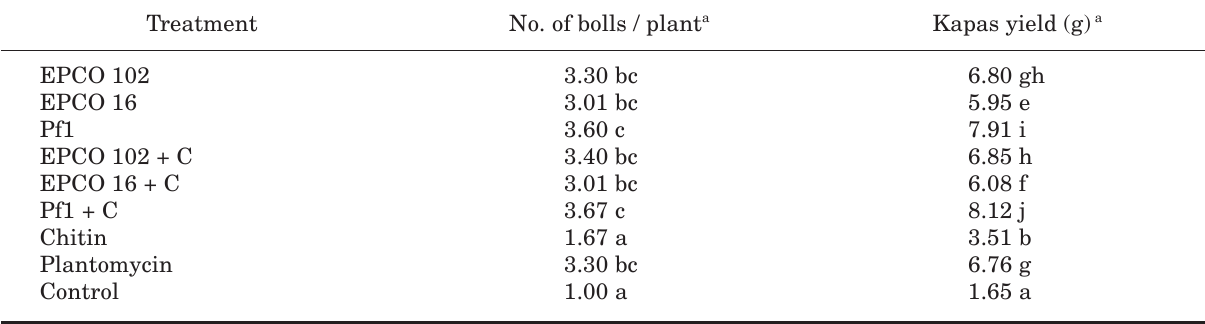
Table 3. Effect of bacterial endophytic strains on cotton yield.